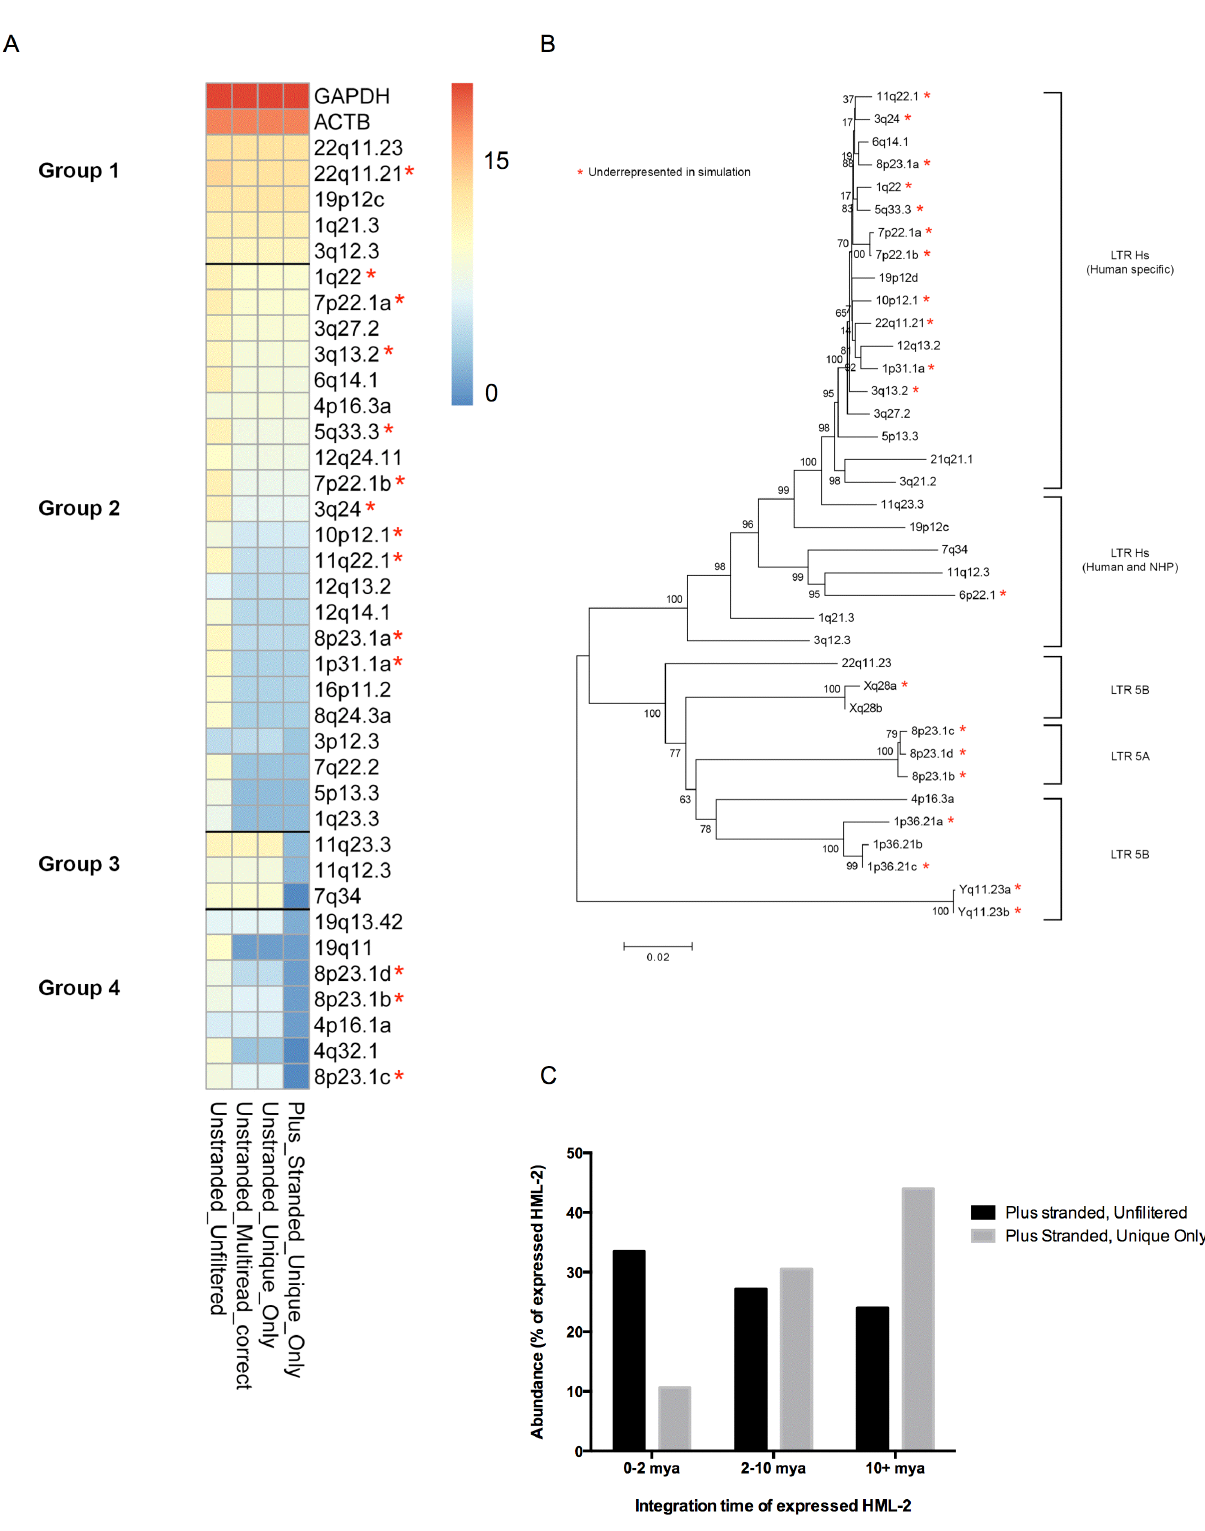
Figure 1. RNASeq analysis of HML-2 expression in Tera-1 cells. ( A ) RNASeq reads derived from Tera-1 cellular RNA were aligned to the hg19 build of the human genome, using either a stranded (“Plus Stranded”) or unstranded (“Unstranded”) alignment. Aligned reads were either kept in full (“Unfiltered”), or were filtered based on mapping quality scores to only retain reads that uniquely aligned to one map location (“Unique Only”). The fragments per kilobase per million mapped reads (FPKM) values representing relative expression